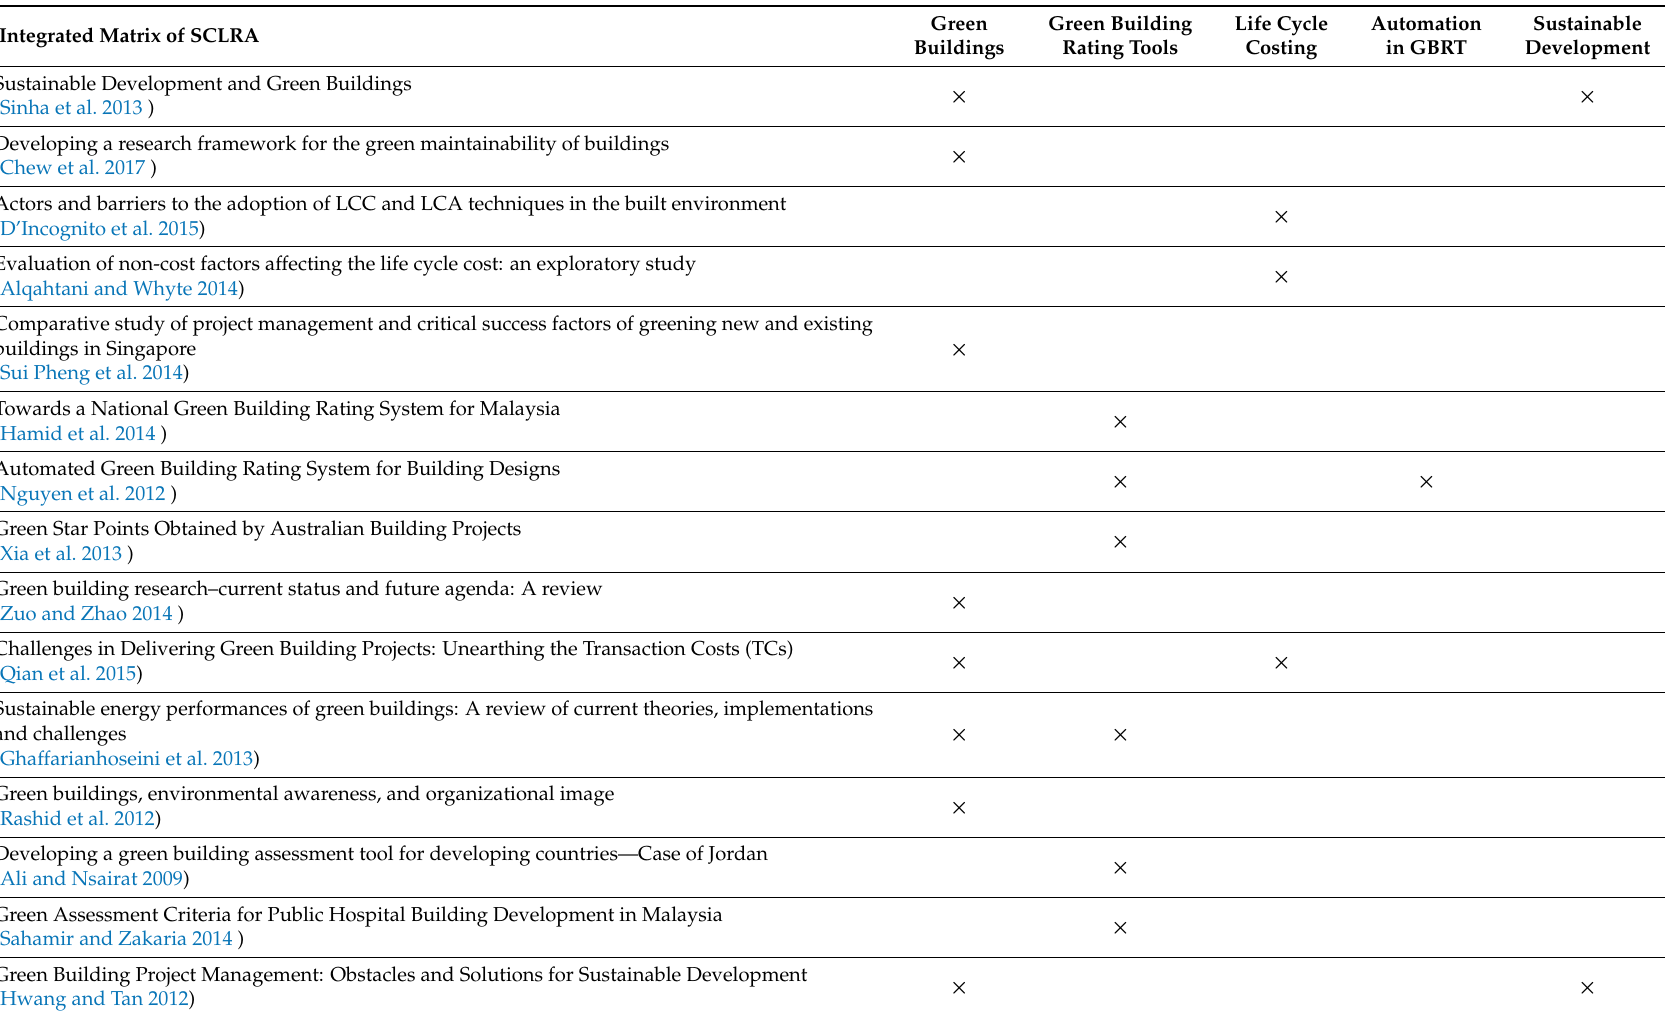
Table 2. Integrated Matrix Selective Critical Literature Review Analysis